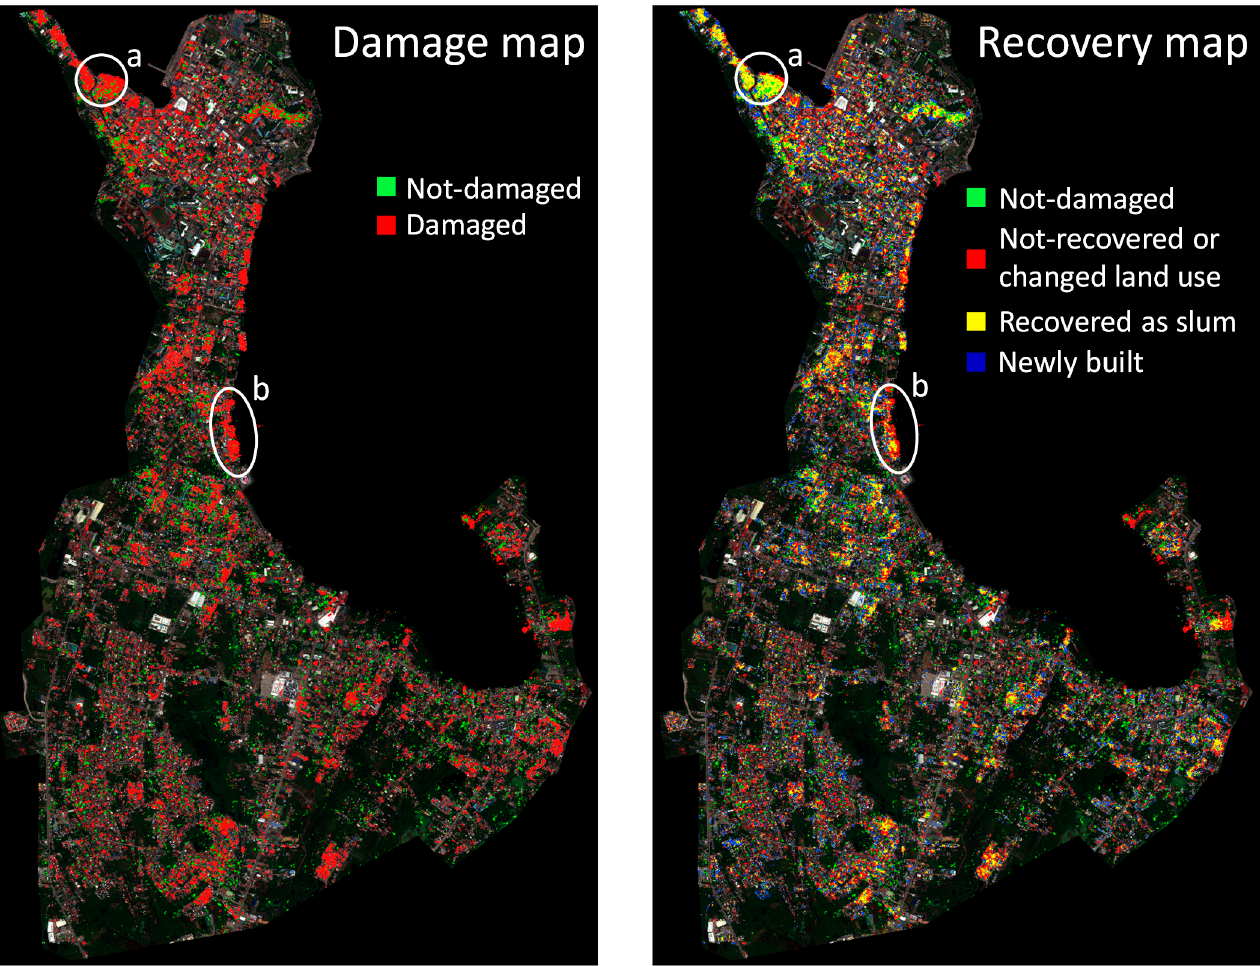
Figure 5. Damage and recovery maps for slum areas after Typhoon Haiyan, and the denoted areas as “a” and “b” show the negative and positive build-back-better goal implementation, respectively.